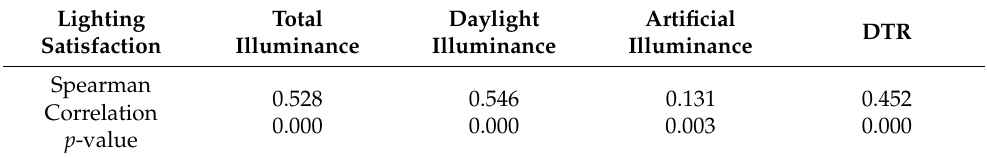
Table 3. Spearman coefficient between lighting satisfaction and lighting level in different conditions.